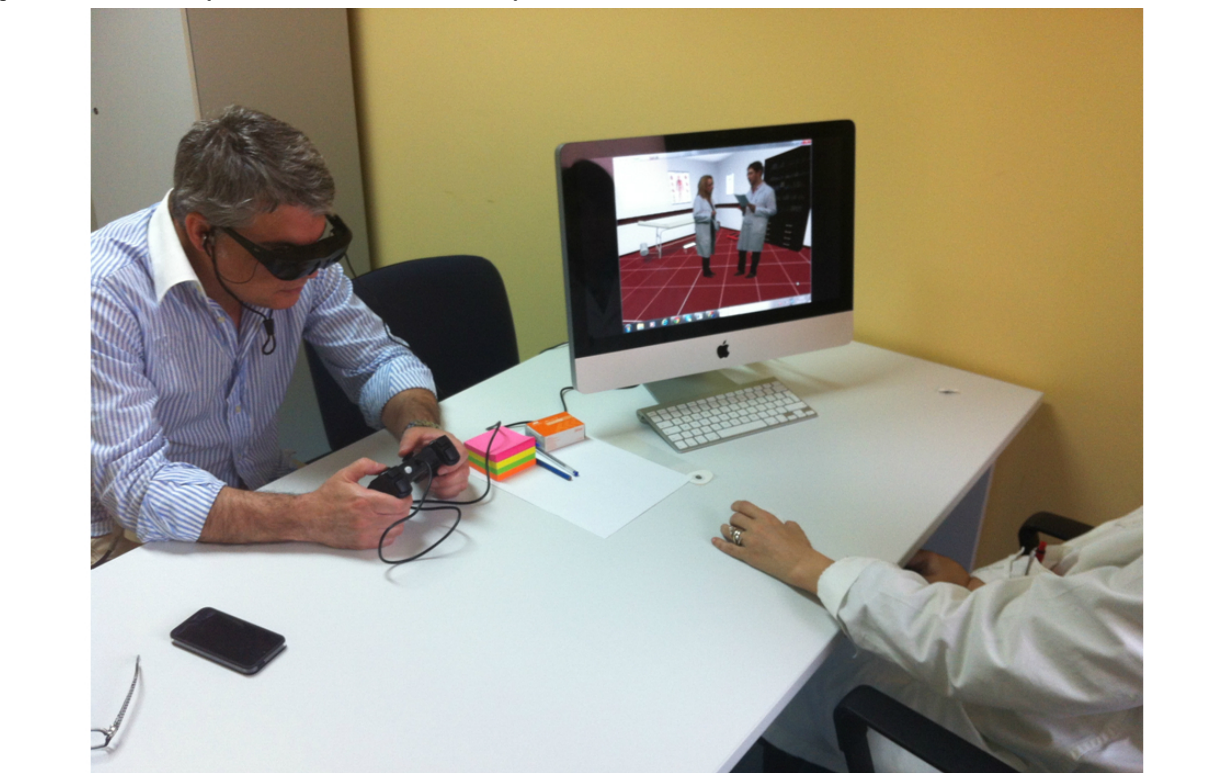
Figure 5. A Virtual Reality treatment session of the Interreality